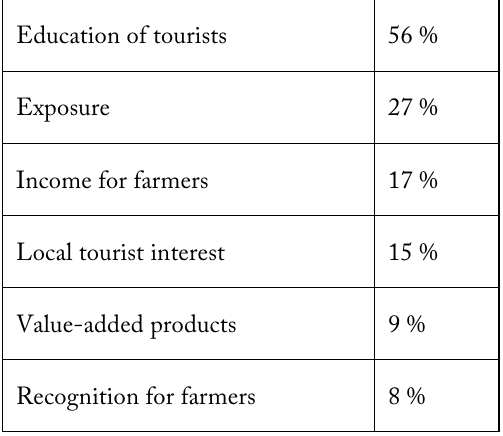
TABLE 1: Possible benefits of agritourism activities on farms as seen by tourists